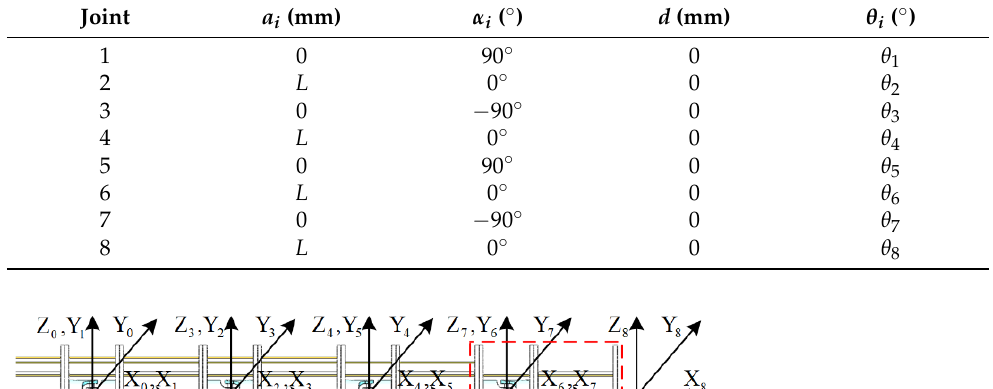
Table 1. D-H Parameters.